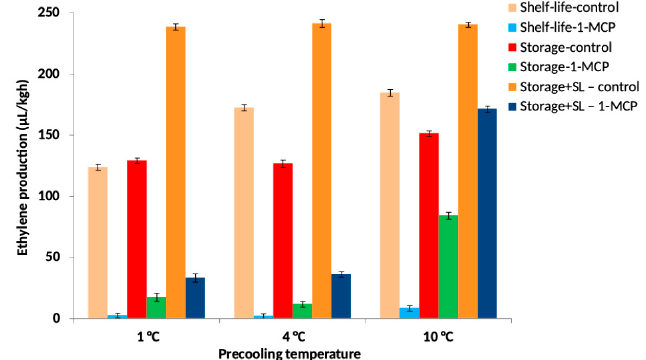
Fig. 2: Ethylene production during experiment (SL: shelf-life). Presented values are mean ± SD.